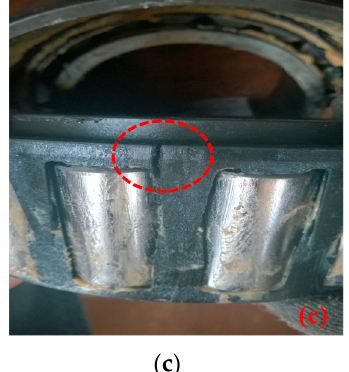
Figure 6. Axle bearing defects: ( a ) three outer race defects; ( b ) a pin roller defect; ( c ) a cage defect.